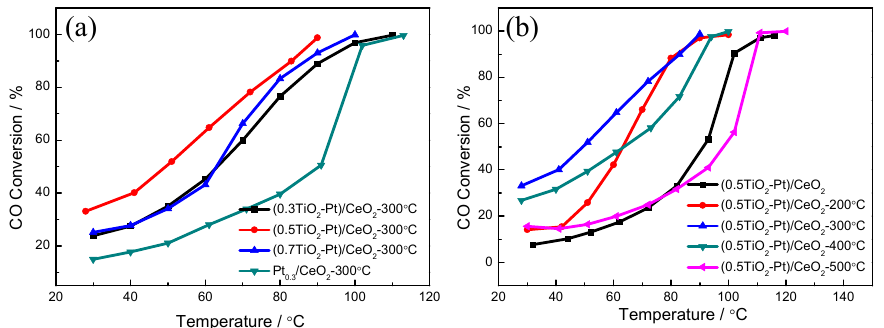
Figure 7. ( a ) The catalytic performance of Pt 0.3 /CeO 2 , (0.3TiO 2 − Pt)/CeO 2 , (0.5TiO 2 − Pt)/CeO 2 , (0.7TiO 2 − Pt)/CeO 2 catalysts; ( b ) the (0.5TiO 2 − Pt)/CeO 2 catalyst obtained at different calcination temperatures. Table 1. Comparison on catalytic performance of (0.5TiO 2 − Pt)/CeO 2 with previous reports